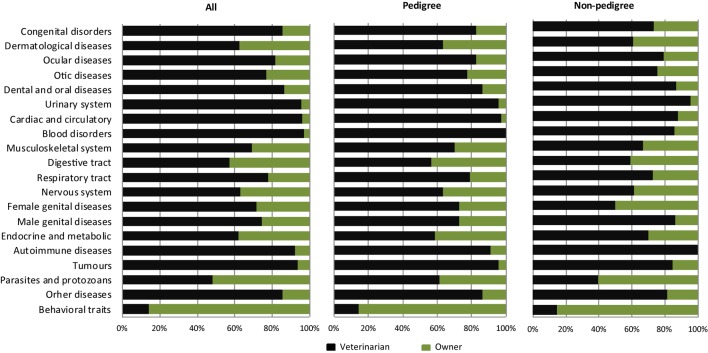
Proportions of disease categories diagnosed by the veterinarian or the owner.